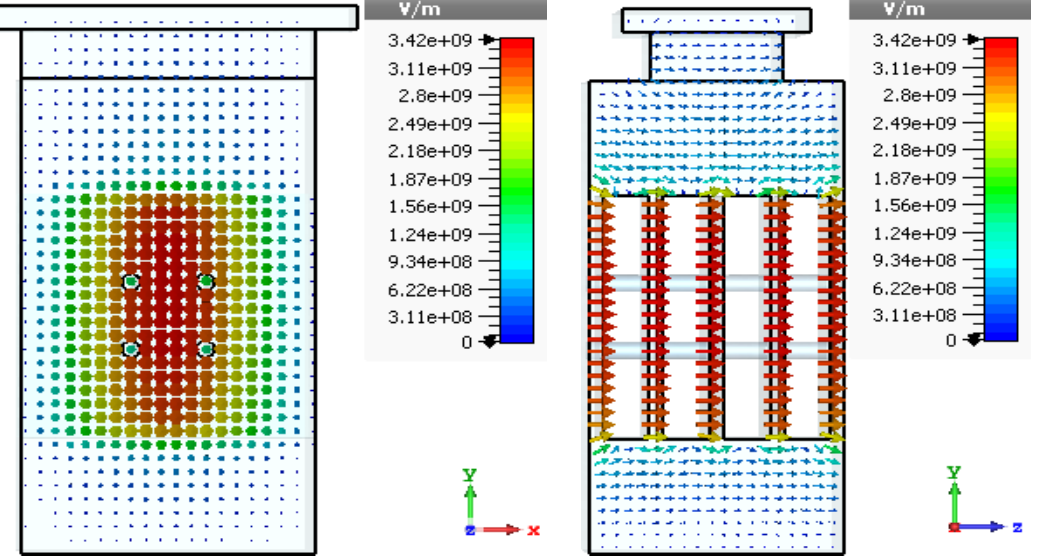
Figure 7. Electric field distribution of the 2 π mode (cut-plane view) for the input and output cavities with CST.